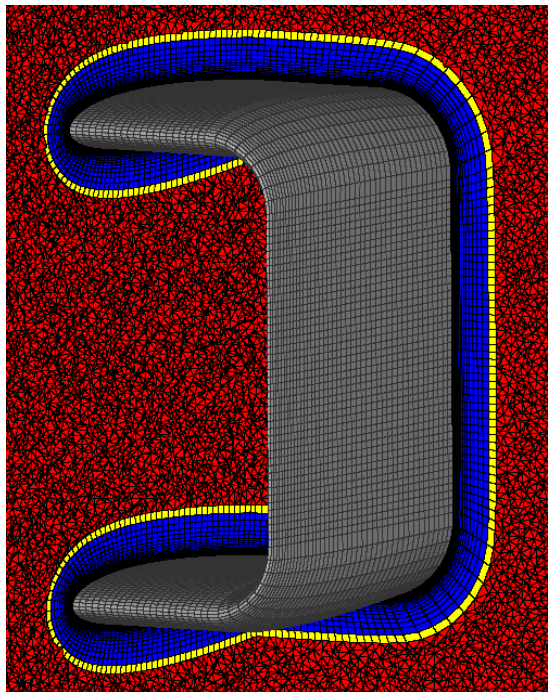
Figure 8. Types of cells in the volume mesh close to the wing surface: hexahedra (blue), pyramids (yellow), and tetrahedra (red) [20].